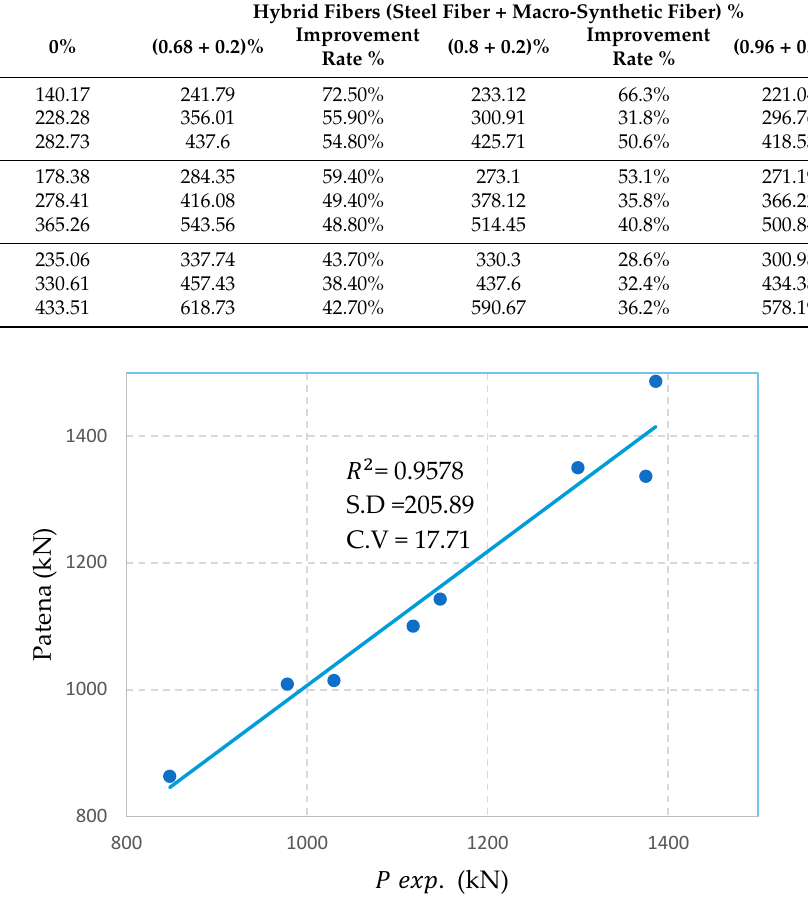
Figure 5. Experimental results versus the FE analysis of load for slab models [22].